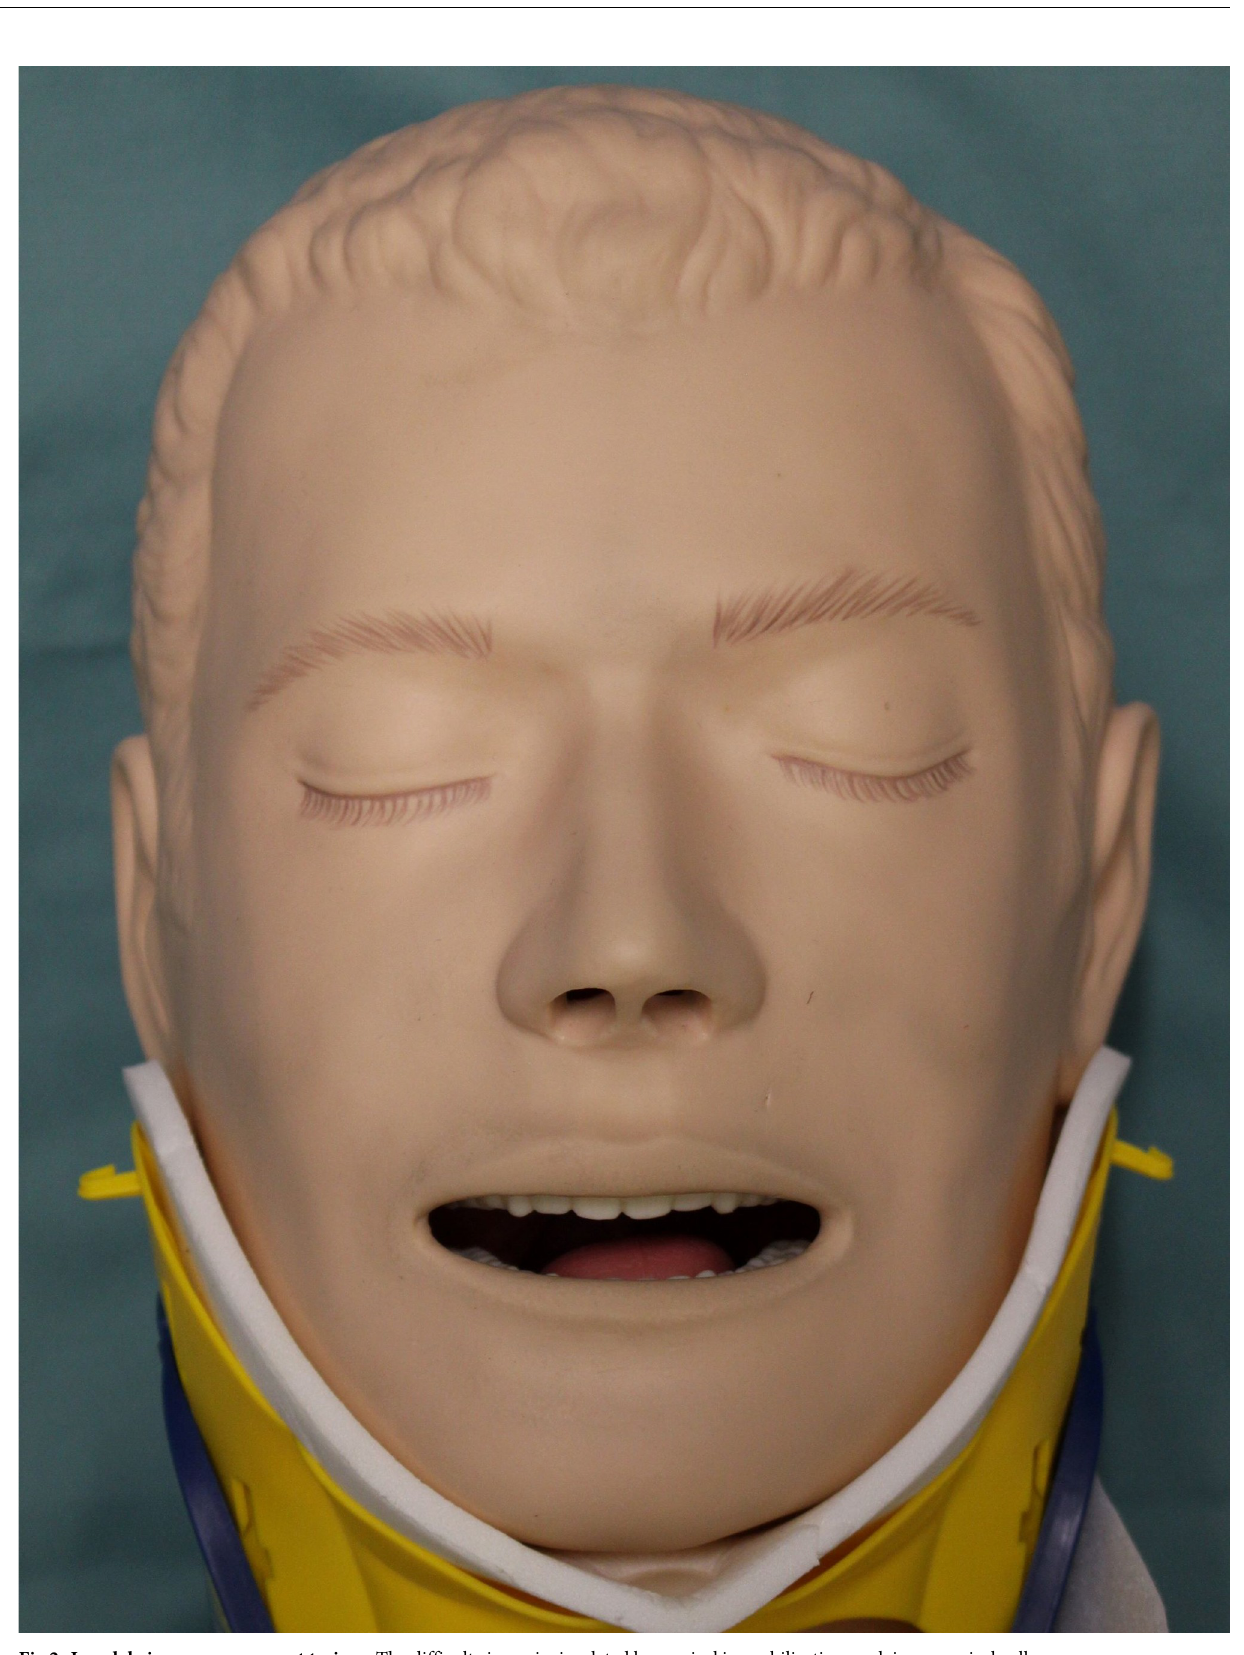
Fig 2. Laerdal airway management trainer. The difficult airway is simulated by cervical immobilization applying a cervical collar. https://doi.org/10.1371/journal.pone.0236474.g002 PLOS ONE | https://doi.org/10.1371/journal.pone.0236474 July 30,